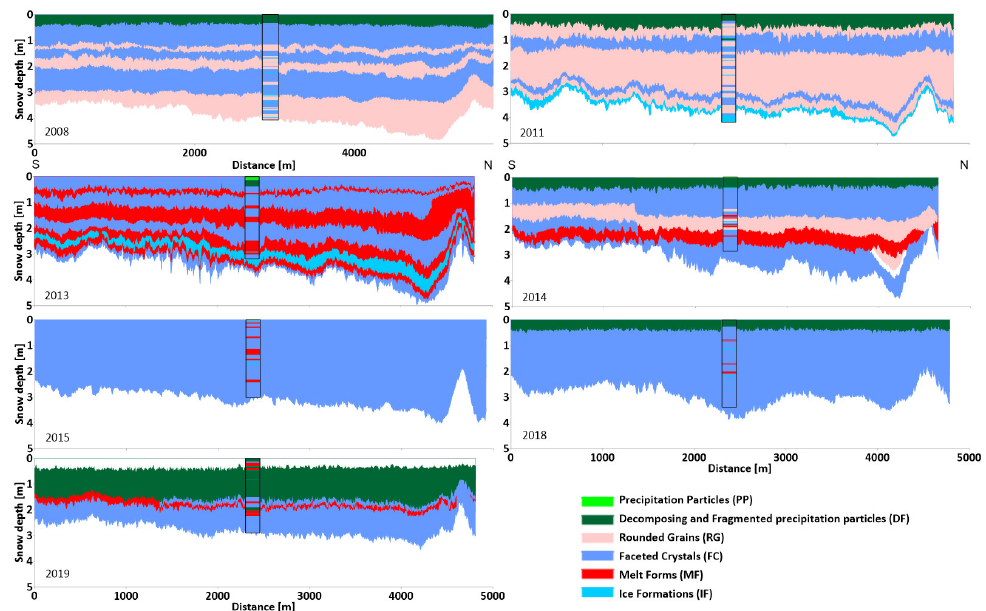
Figure 4. Grain Shape. The white color refers to layers with undefined grain shape. Vertical rectangles in the middle of the GPR profiles denote HS and the grain shape in the snow pits (H9). See the location of the GPR profiles on Figure 1.